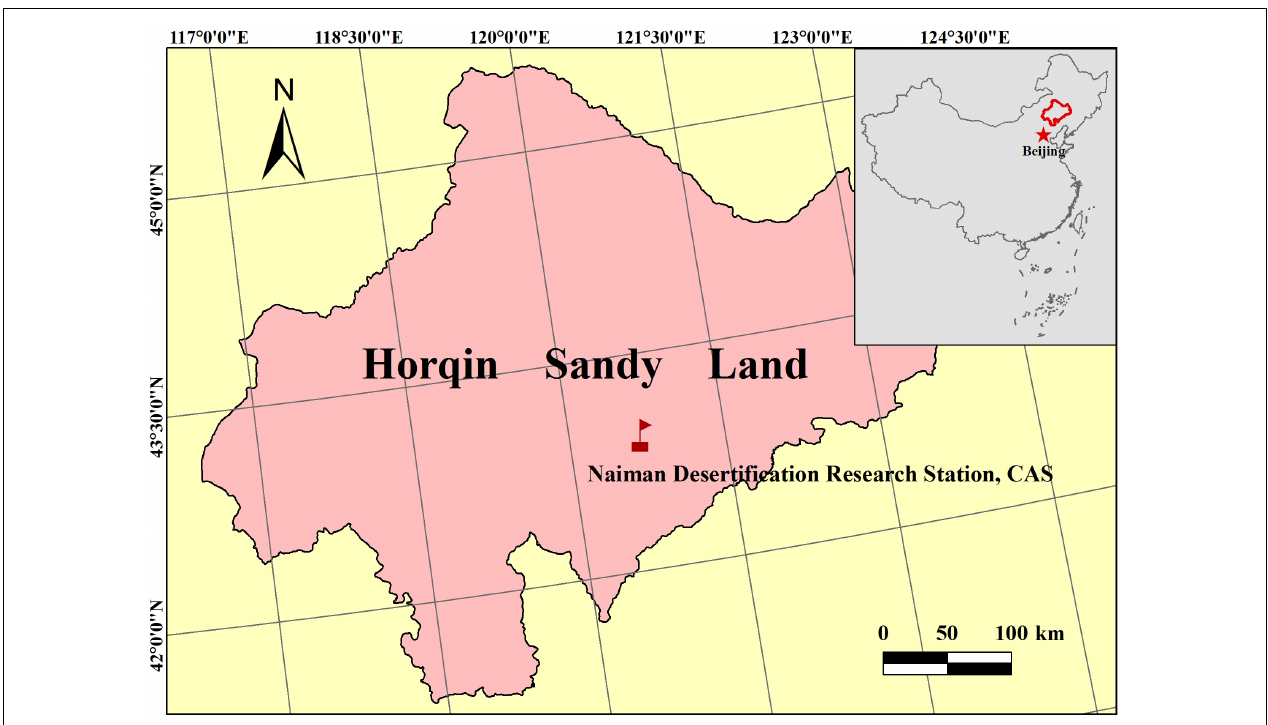
FIGURE 1 | Study area of Naiman Desertification Research Station (NDRS), in the southeastern part of Inner Mongolia, typical area in agro-pasture ecotone of northern China.